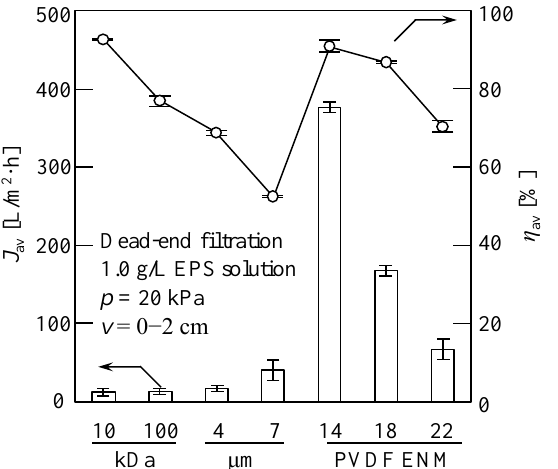
Figure 3. Average water flux ( J av ) and average EPS recovery rate ( η av ) in the dead-end filtration of a 1.0 g/L EPS solution. A filtration pressure of 20 kPa was used, and the evaluated data were obtained for the cumulative filtrate volume per unit membrane area, v = 2 cm. Millipore ultrafiltration membranes (MWCO = 10 and 100 kDa), Advantec filter paper (4 and 7 µ m), and the prepared PVDF ENMs (PVDF mass fractions of 14, 18, and 22 wt.%) were evaluated.